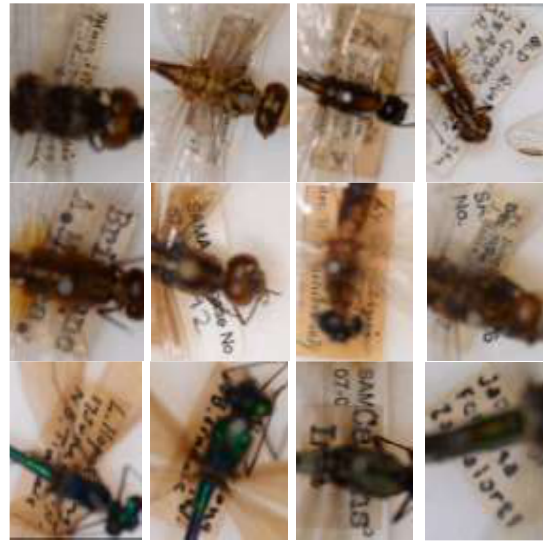
Figure A- Labeling of typical specimens at South Australian Museum Figure A1. Labeling of typical specimens at South Australian